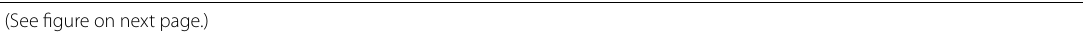
Fig. 8 Cold-induced mitochondrial fission despite the presence of the Drp1 inhibitor Mdivi-1. Porcine aortic endothelial cells (control, A , I ) were incubated at 4 °C for 3 h, 6 h and 24 h with 20 µM Mdivi-1 ( E – H , M – P ), a potent Drp1 inhibitor. DMSO was added as solvent control ( A – D , I – L ). Mitochondria were stained with MitoTracker Red. Additionally, Drp1 immunofluorescence (green) staining was applied ( I – P ). The images were documented by fluorescence microscopy (MitoTracker Red: λ exc. Representative figures of n 4 experiments. For quantification of mitochondrial fission ( Q ) cells were categorised in cells with predominantly short, = intermediate and long mitochondria by a person blinded to the experiment. Means